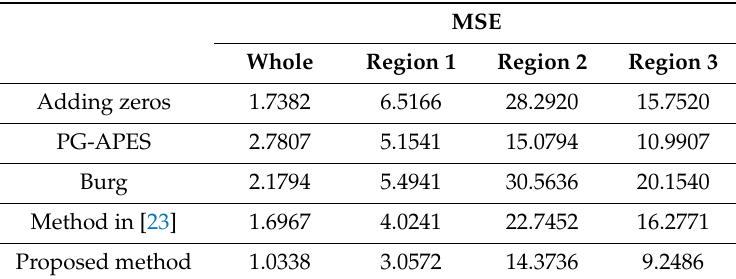
Table 8. MSE analysis for the results of real SAR data